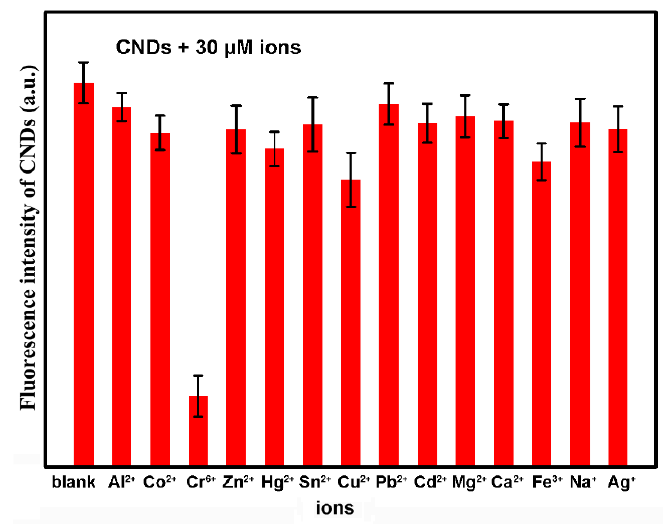
Figure 10. Selectivity of the CNDs for Cr(VI) over other metal ions. The fluorescent intensity indicated the PL of the 360 nm peak of the CNDs (excited at 260 nm) with 30 μM ions.